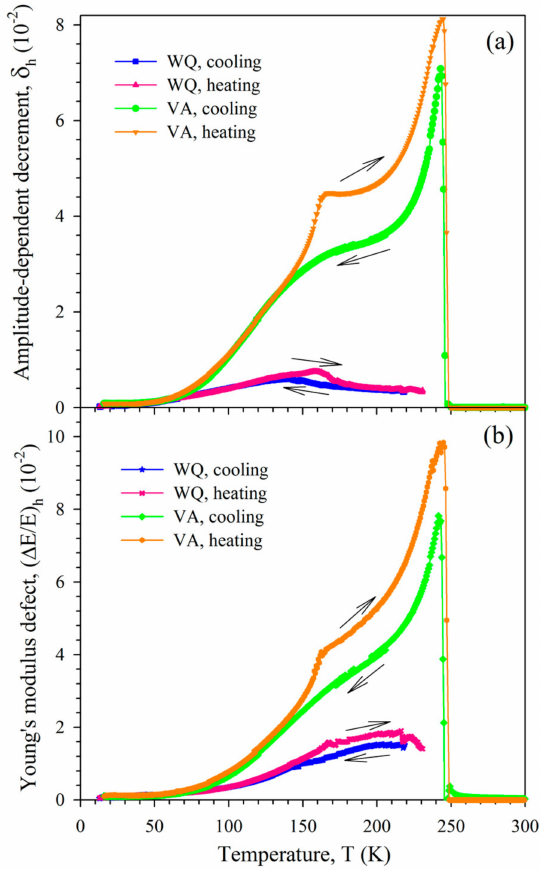
Figure 4. Temperature dependence of the amplitude-dependent components of the decrement ( a ) and Young’s modulus defect ( b ) of the Ti 50 Ni 46.1 Fe 3.9 sample measured in a cooling-heating cycle after water quenching (WQ) or vacuum annealing (VA). The dependence is derived from the temperature spectra of the decrement and effective Young’s modulus measured at strain amplitudes of 10 − 6 and 5 × 10 − 5